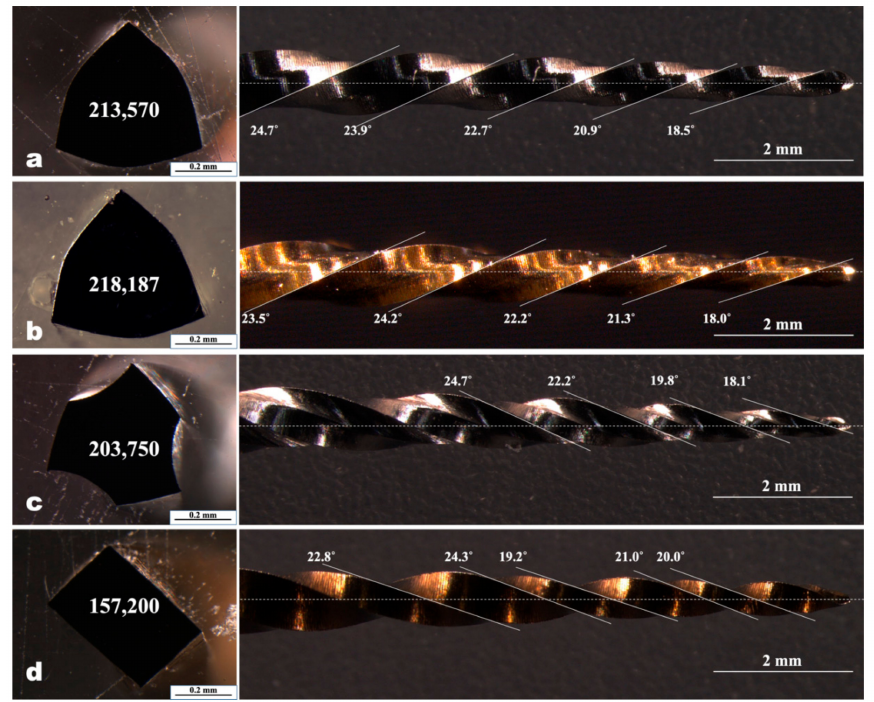
Figure 1. Cross-sectional shape and area ( µ m 2 ) at the level of D4 (left), and longitudinal geometry showing helical angle and pitch (right). ( a ) ProTaper Universal F2; ( b ) ProTaper Gold F2; ( c ) WaveOne Primary; ( d ) WaveOne Gold Primary.